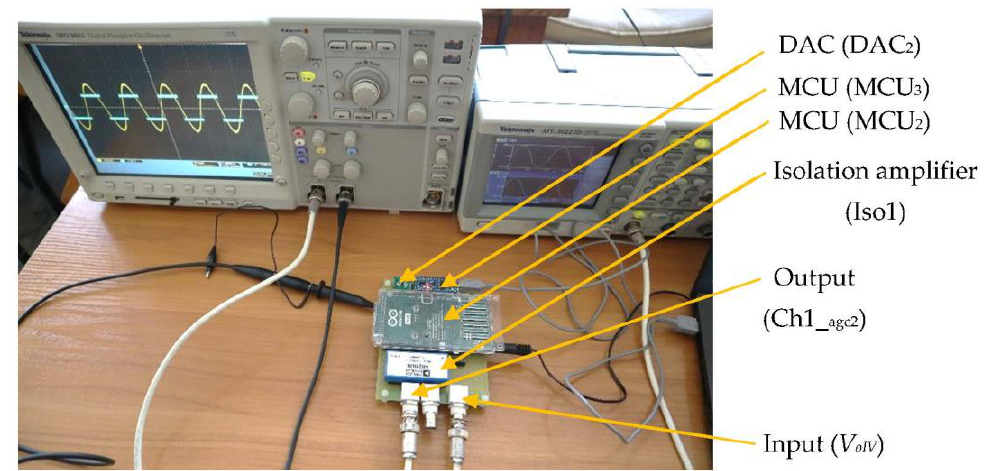
Table A1. List of elements from the circuit AGC in Figure A1.